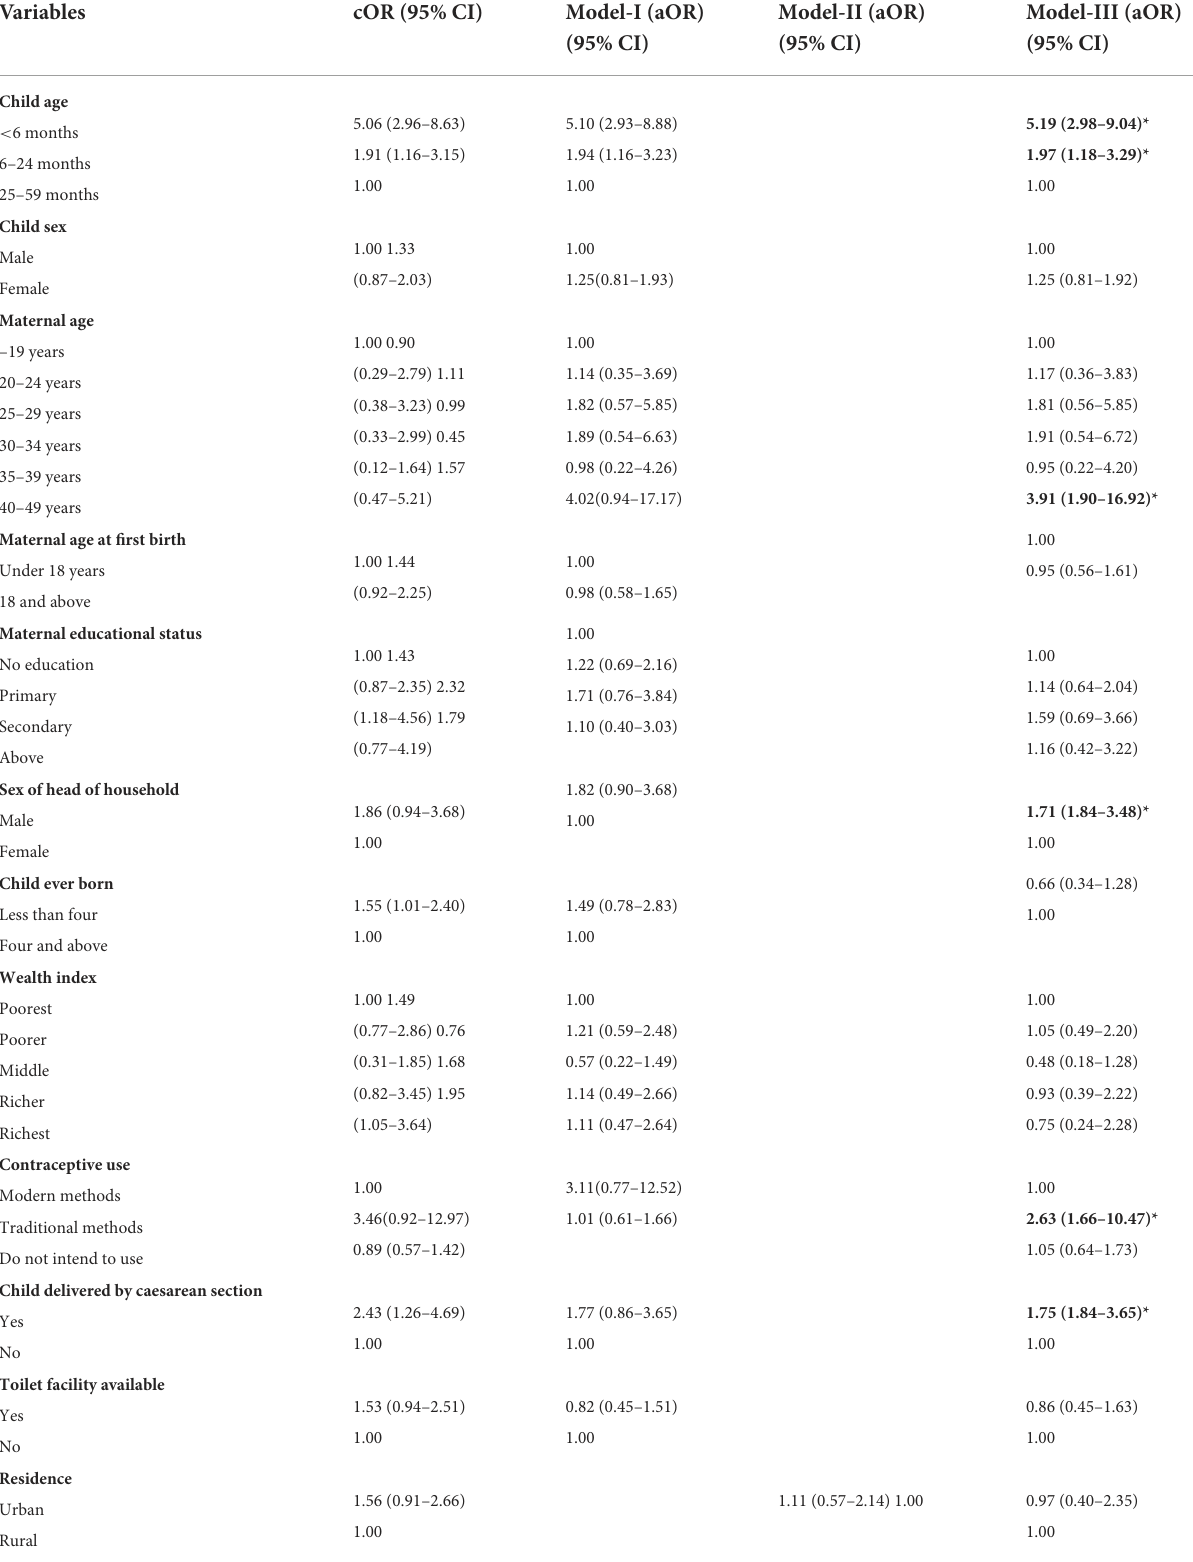
TABLE 4 Multilevel binary logistic regression analysis for factors associated with overweight/obesity in under-five children, in